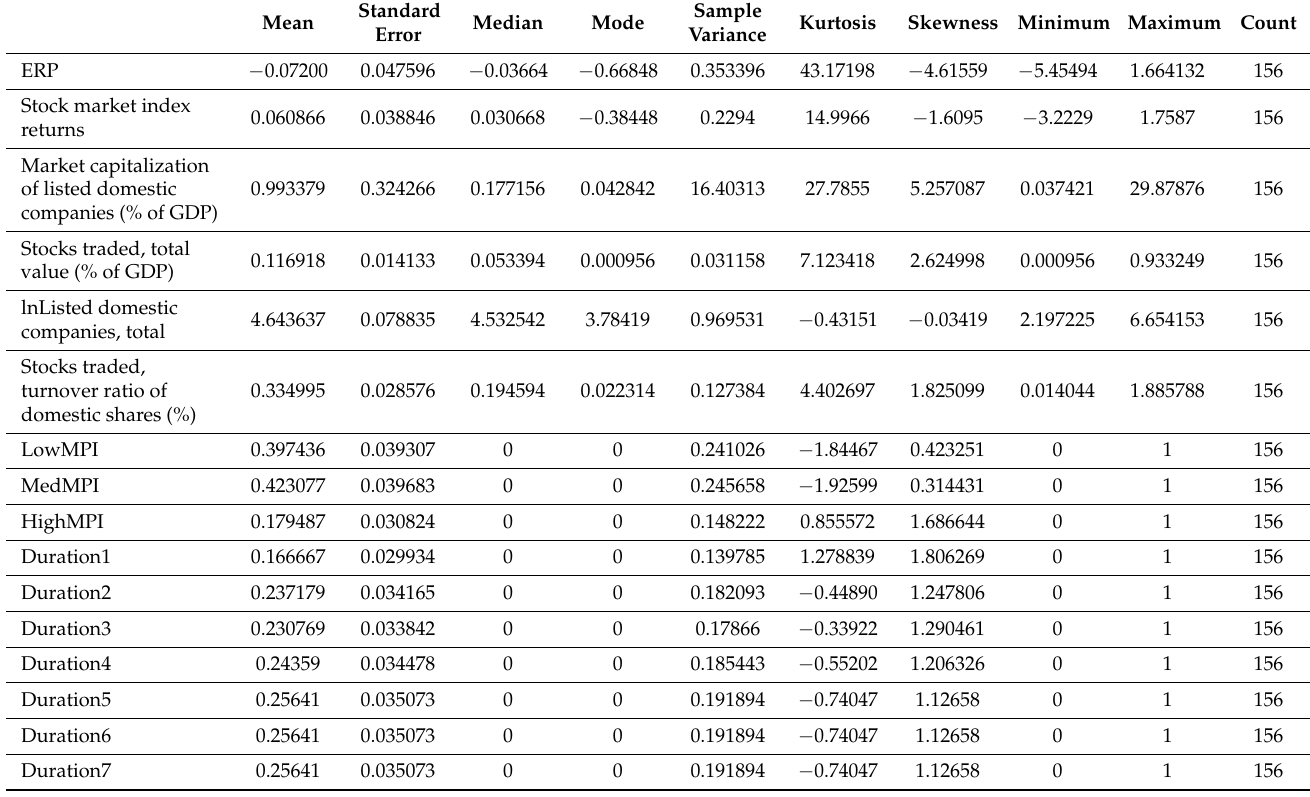
Table A2. Descriptive statistics for the low level of stock market